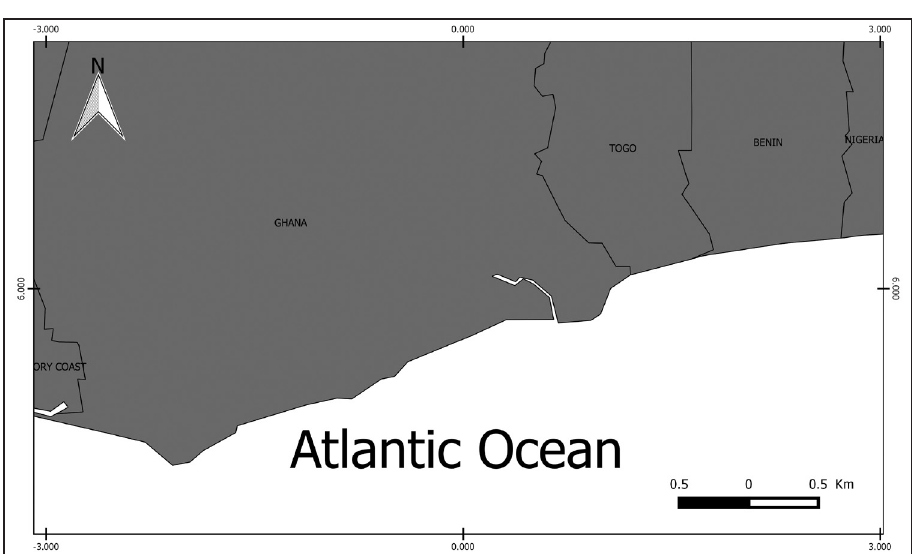
Figure 1. Region of the record Datasets of sea turtles (coastal areas of Ghana, Togo and Benin).